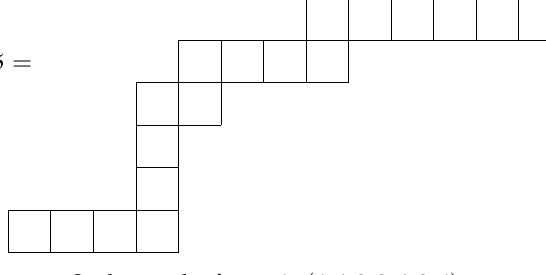
Figure 2. Snake graph of type S f ( 4,4,2,2,4,2,6 ) .